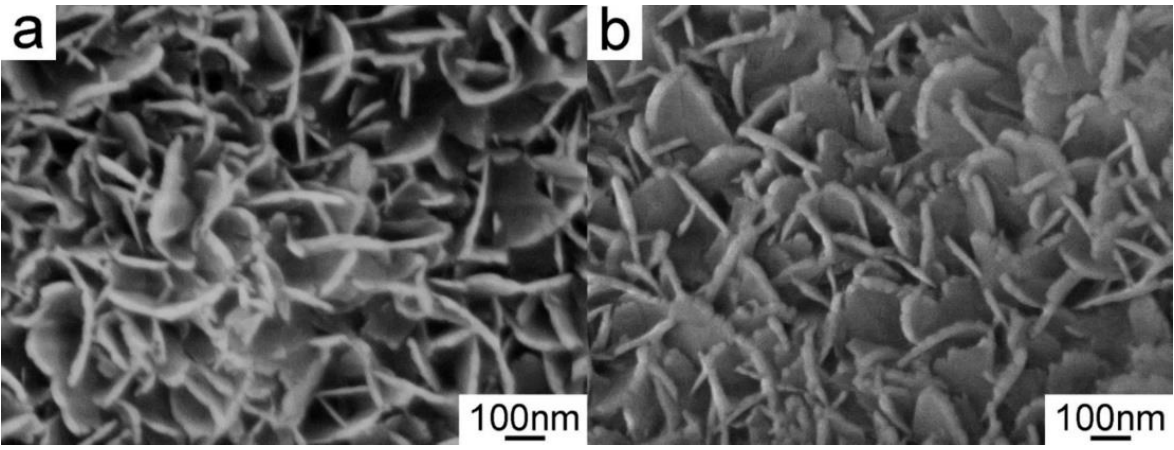
Figure 7. Surface morphologies of ( a ) A23H6 and ( b ) A27H6.